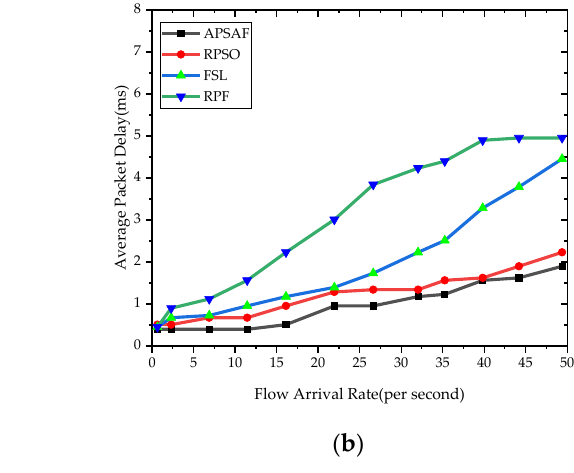
Figure 9. ( a ) Average Packet Delay; ( b ) Average Packet Delay.